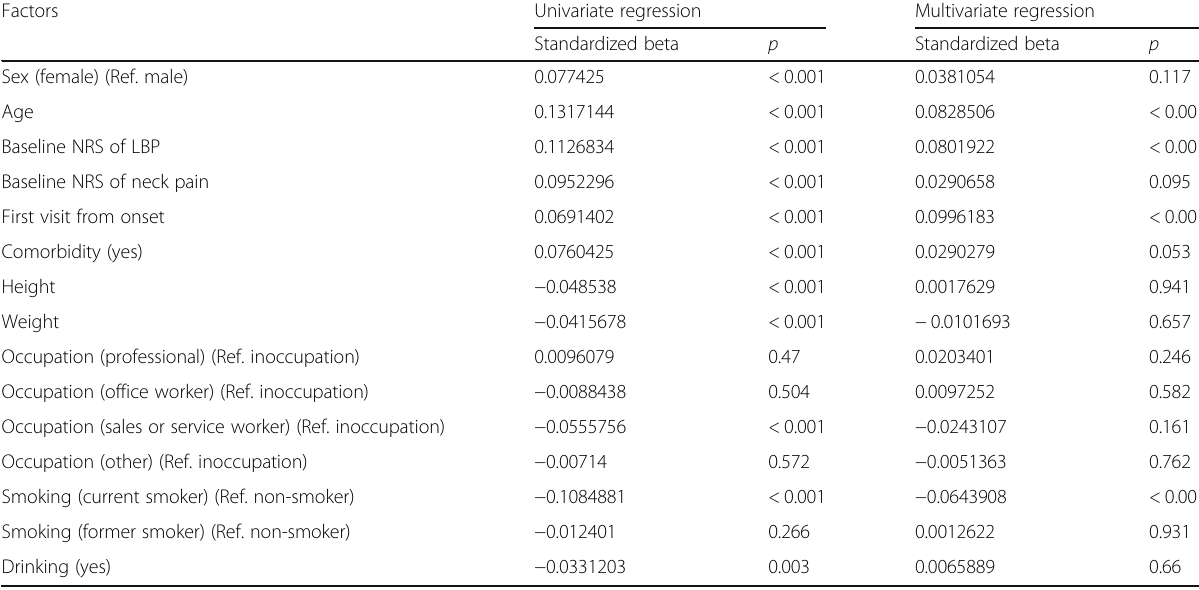
Table 4 Analysis of baseline factors potentially predictive of total treatment